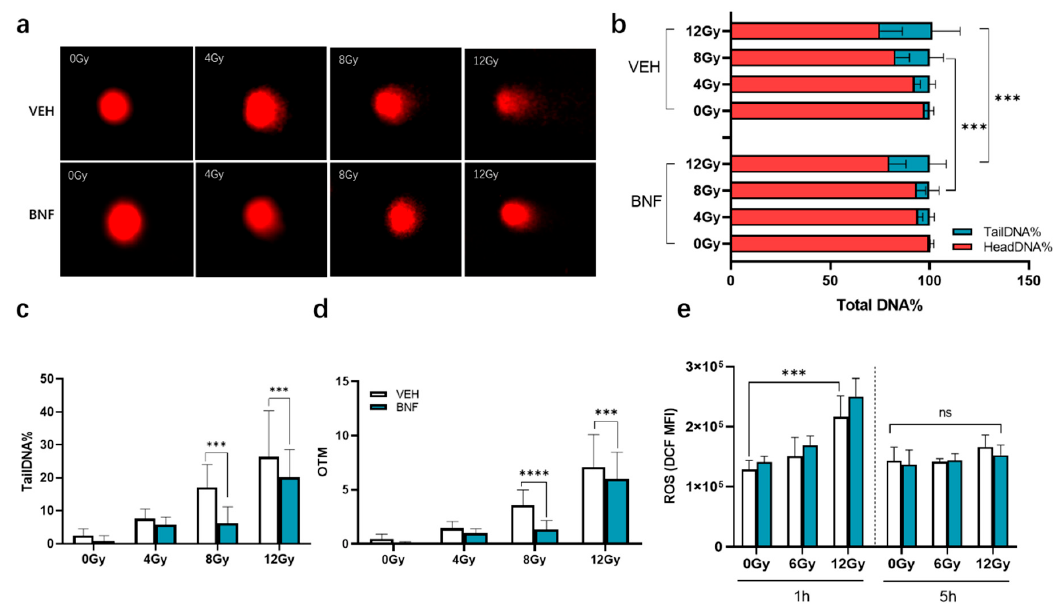
Figure 4. BNF diminishes the DNA strand breakage in IEC-6 cells exposed to irradiation. ( a ) Cell images of comet assay after various levels of radiation. ( b – d ) Percentage of head, tail DNA and olive tail moment based on comet assay. Percentage of DNA is quantitated by CASP1.2.1 software. ( e ) ROS level in irradiated IEC-6 cells. Cells were pretreated with 1 µ M BNF or vehicle prior to irradiation and were harvested after irradiation exposure at 1 and 5 h and measured in a flow cytometer. Data represent the mean fluorescence intensity ( n = 3) ± standard error (SD). Results were analyzed by one- or two-way ANOVA (Significance: *** p < 0.001, **** p < 0.0001). The term “ns” is defined as not